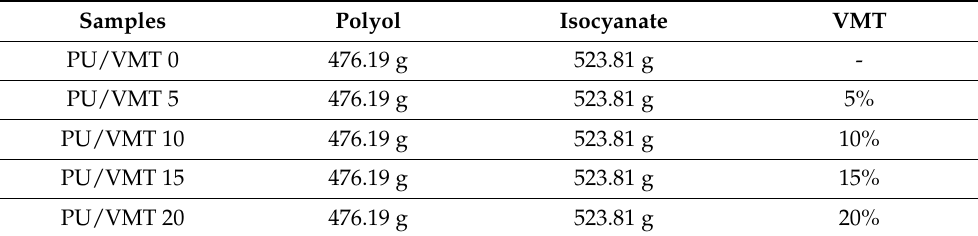
Figure 1. Stages of preparation of rigid polyurethane foams. Stages of preparation of rigid polyurethane foams. ( 1 ) Vermiculite (VMT) dispersed in the polyol before adding the isocyanate; ( 2 ) MDI isocyanate was added to the mixture; ( 3 ) The mixture was then quickly poured into a mold to produce PU foam; ( 4 ) The molds containing PU were kept at room temperature for 24 h ( 5 ) PU foams. Table 1. PU/VMT composite